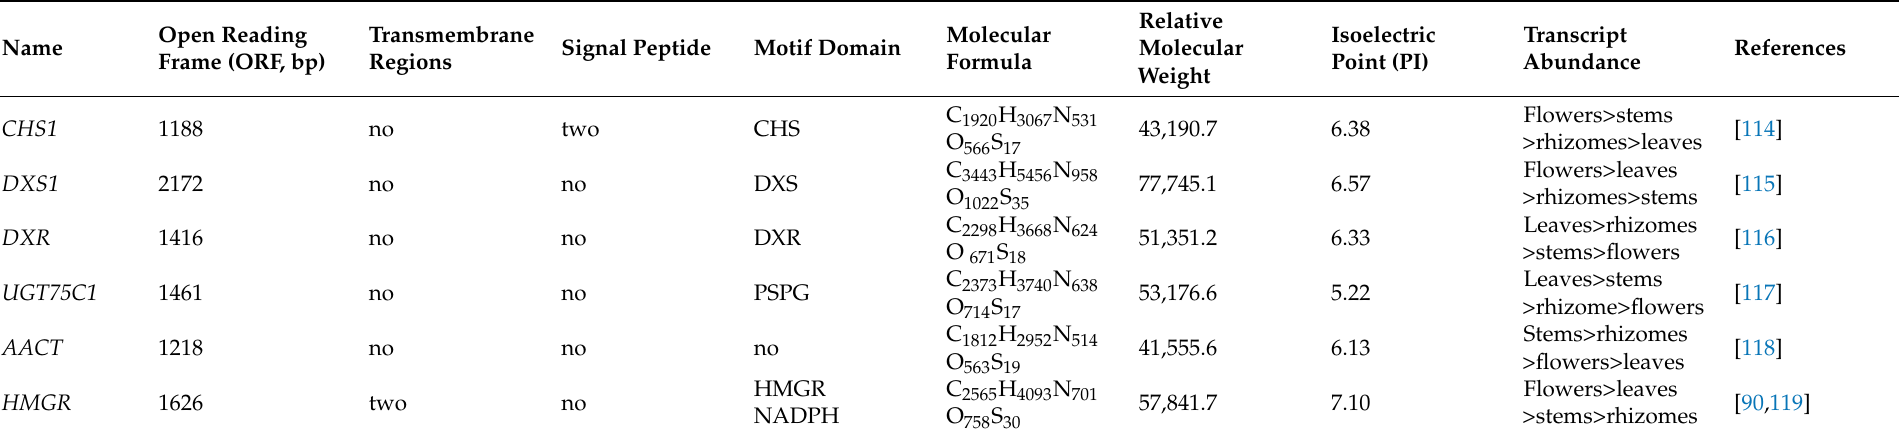
Table 2. Cloning and studiesof gene function in H. cordata